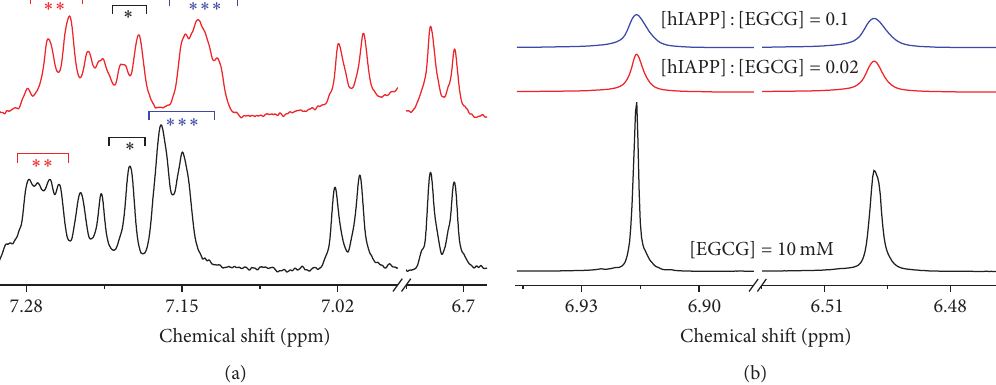
Figure 8: Interactionbetween hIAPP and EGCG. (a) Aromaticregions of 1 H NMRspectra of 100 𝜇 M hIAPP with (top) and without (bottom) 1mM EGCG. One ( ∗ ), two ( ∗∗ ), and three ( ∗ ∗ ∗ ) asterisks represent 𝐻 𝛿 of His18, 𝐻 𝜀 , and 𝐻 𝜁 of Phe15/Phe23 residues, respectively. (b) 1 H NMR spectra of 1mM EGCG in ratio of [hIAPP]: [EGCG] of 0 (bottom), 0.02 (medial), and 0.1 (top) 𝜇 M hIAPP within chemical shift from 6.47 to 6.95 ppm in D 2 O under 25 ∘ C.